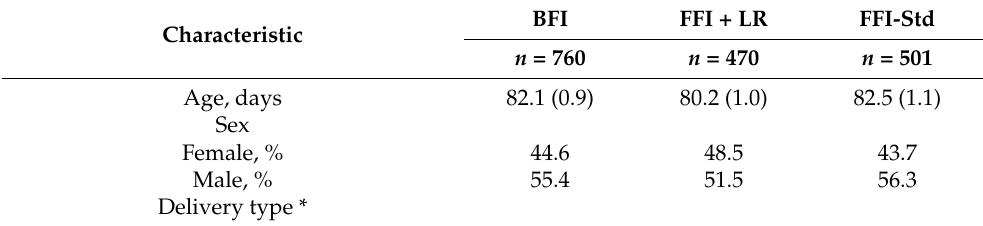
Table 1. Demographic, anthropometric and parental characteristics of studied